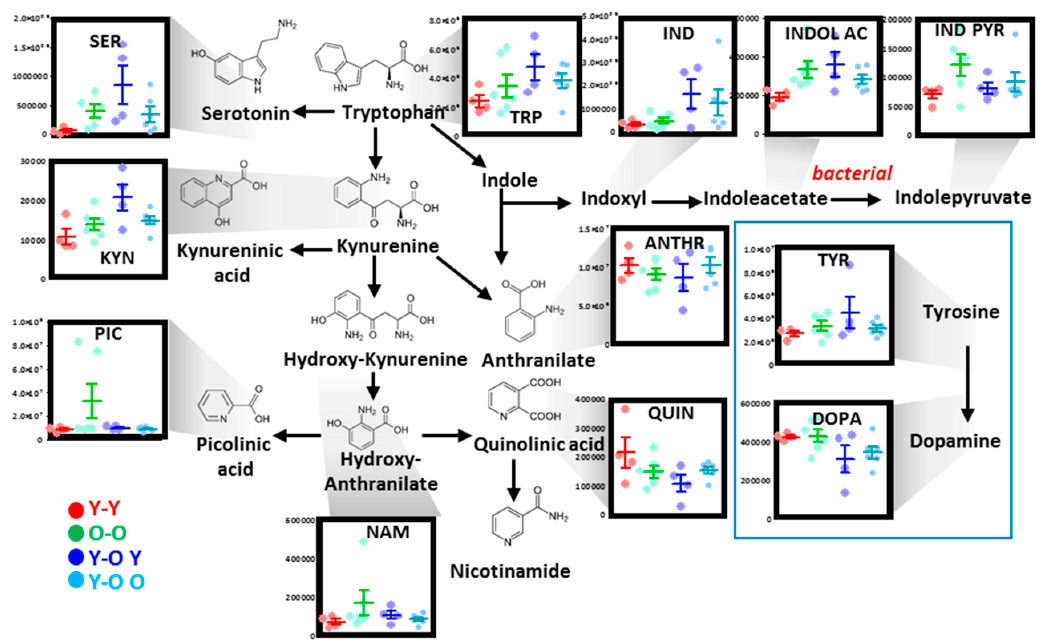
Figure 8. Alterations of RBC tryptophan metabolism in isochronic and heterochronic parabiotic mice. Dots represent distinct biological replicates for isochronic young–young (red) or old–old (green), or heterochronic Y–O mice with blood being drawn from the young mouse (blue) or the old mouse (light